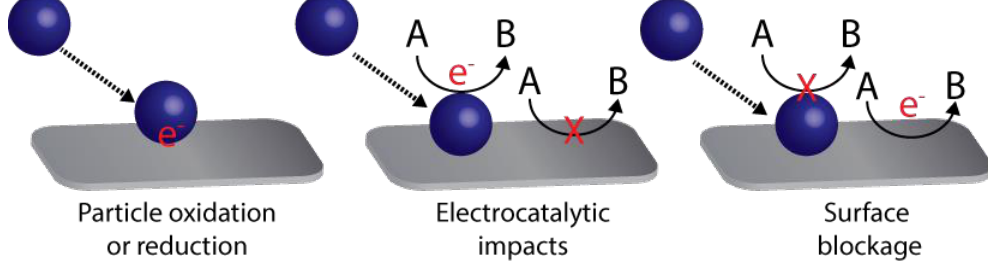
Figure 8. Different electrochemical approaches to detect collisions of nanoparticles.